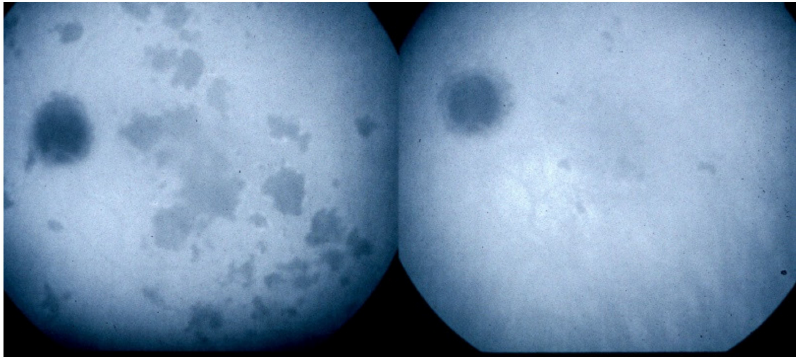
Figure 10. APMPPE/AMIC. Geographic areas of ICGA